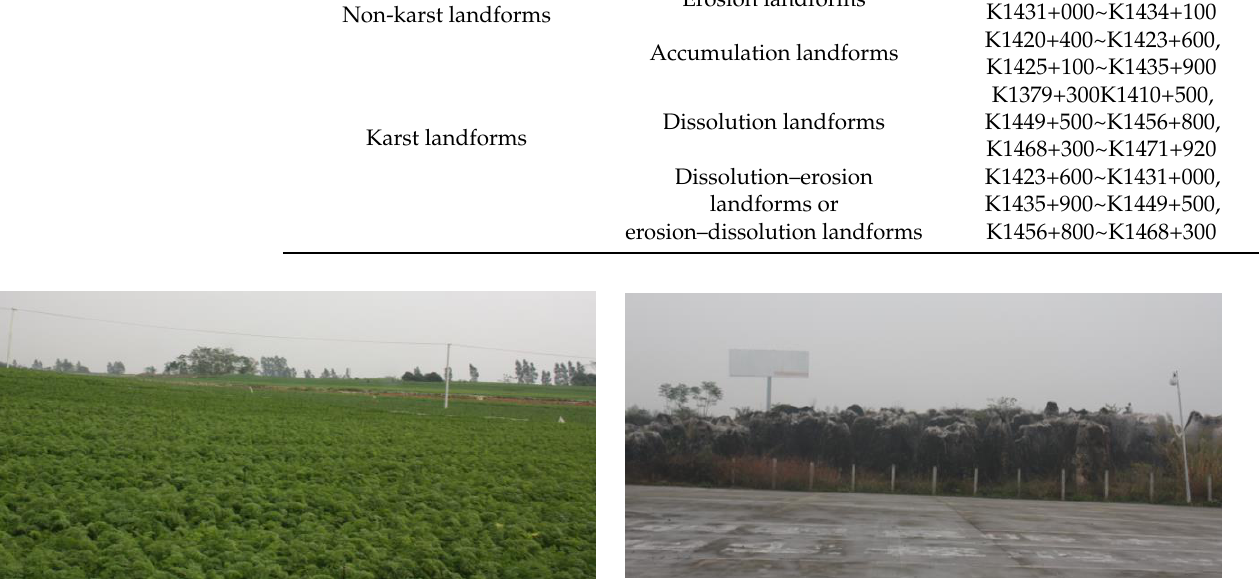
Figure 4. Typical dissolution landforms. Table 2. List of landform types in the study